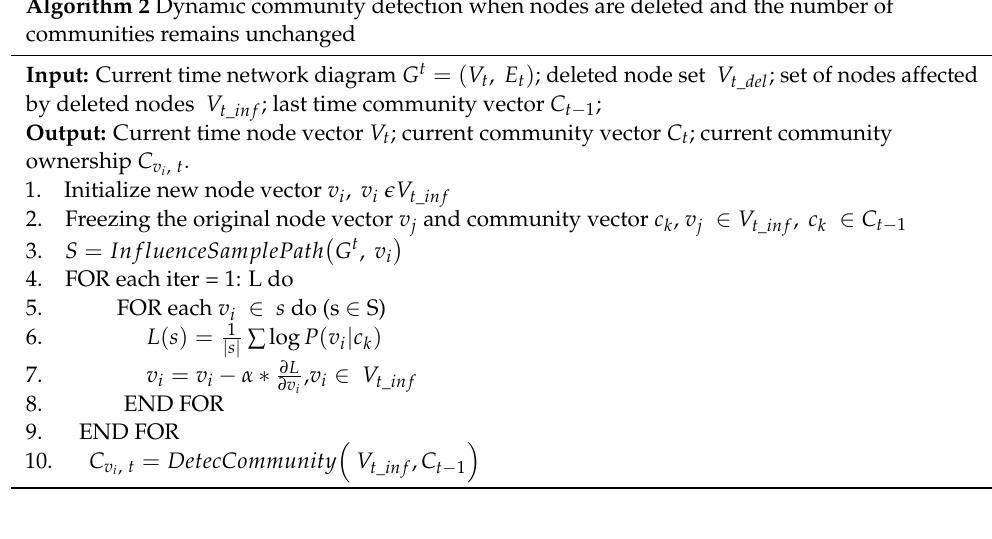
Algorithm 2 Dynamic community detection when nodes are deleted and the number of communities remains unchanged